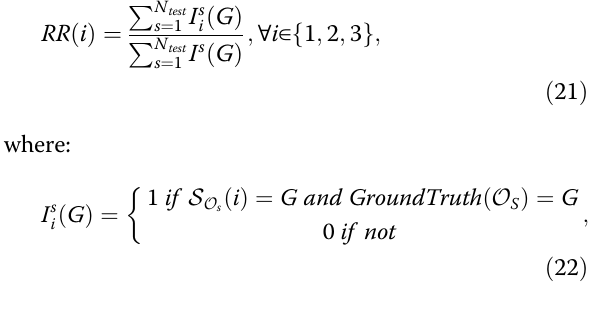
Table 5 Confusion matrix (HTI 2014 – 2015 dataset)